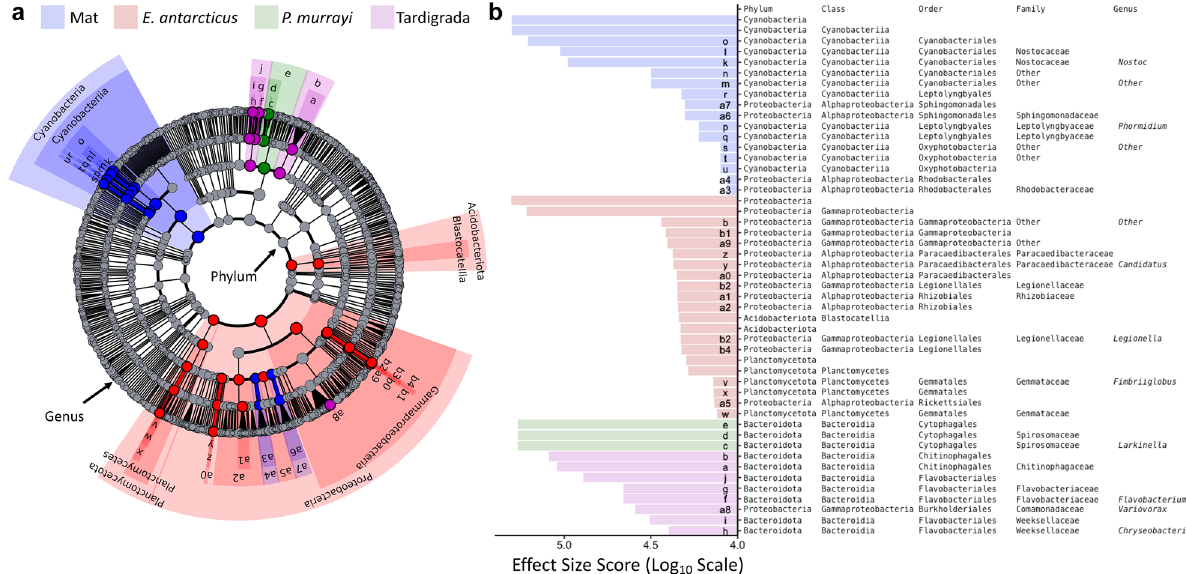
Figure 4. LEfSe (Linear Discriminant Analysis Effect Size) analysis displaying enrichment of most significant bacterial taxa at different levels of taxonomic resolution within mat, nematode ( E. antarcticus and P. murrayi ) and Tardigrada microbiomes. Results are visualized in a cladogram with ( a ) circles representing different ranks of taxonomic classification (phylum as the most inner and genus as most outer circle) and community specific significant clades ( P < 0.05) colored in blue (mats), red (E. antarcticus ), green ( P. murrayi ), purple (Tardigrada) determined with Kruskal–Wallis and Wilcoxon test. ( b ) LDA effect size scores of each significant clade